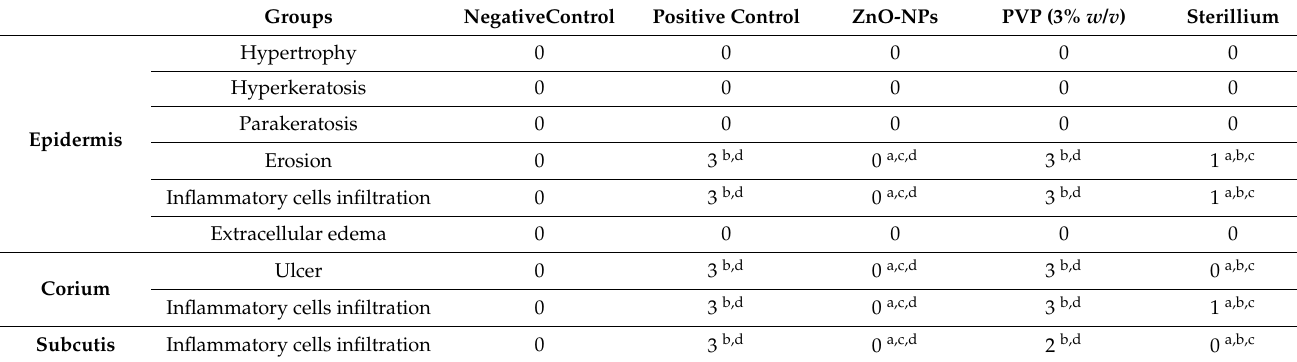
Table 5. Hirasawa scoring of histopathological alterations in skin.